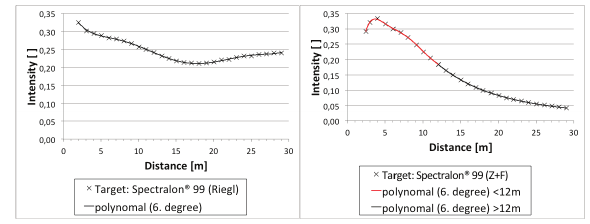
Figure 9. Fitted polynom Riegl (left) and Z+F (right)